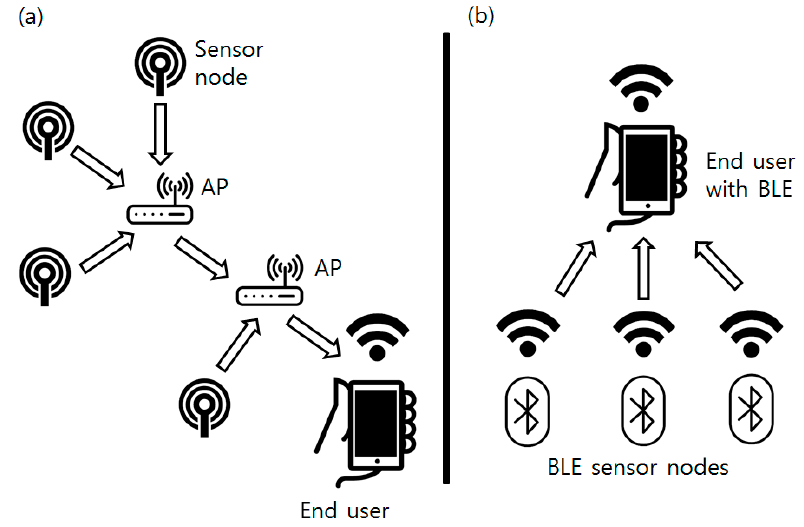
Figure 9. ( a ) Network configuration of the classical mesh topology sensor networks; ( b ) Network configuration used in this research.